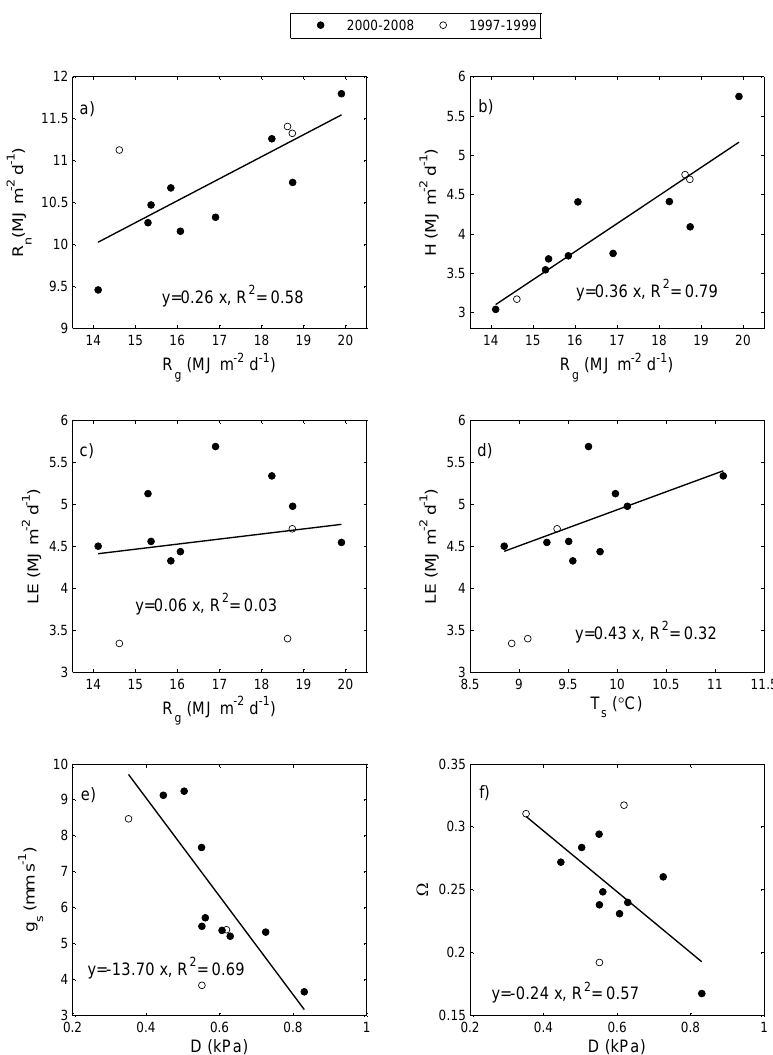
Fig. 10. Mean summertime (May–August) (a) net radiation ( R n ), (b) sensible heat flux ( H ), (c) – (d) latent heat flux (LE) and (e) daytime (08:00–20:00) surface conductance ( g s ) and (f) daytime de-coupling coefficient ( (cid:127)) regressed along their best explaining environmental variable. R g , T s and D are four-month mean global radiation, soil temperature and vapor pressure deficit, respectively. The three first years (1997–1999) characterized by poorer energy balance closure are shown with open symbols. The linear least squares regressions are for years 2000–2008 except in panels (a) and (b) where all years are included. Only regression slopes are shown. R 2 indicates the proportion of explained